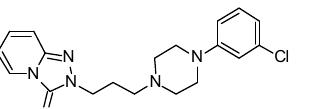
Figure1. Chemicalstructureoftrazodone(2-{3-[4-(3-chlorophenyl)piperazin-1-yl]propyl}[1,2,4]triazolo[4,3- Figure 1. Chemical structure of trazodone (2-{3-[4-(3-chlorophenyl)piperazin-1- a]pyridin-3(2 H yl]propyl}[1,2,4]triazolo[4,3-a]pyridin-3(2 H )-one).